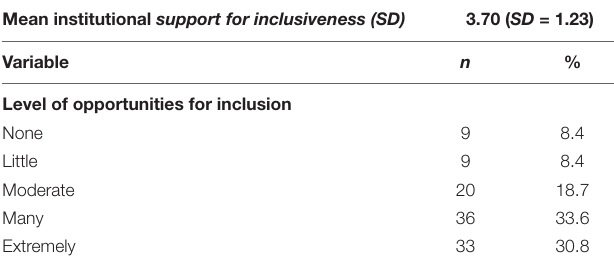
TABLE 2 | Preschool personnel perceptions regarding their institution offering opportunities for inclusion of children with disabilities aged 3–6 years (responses from a total of 107 preschool personnel).